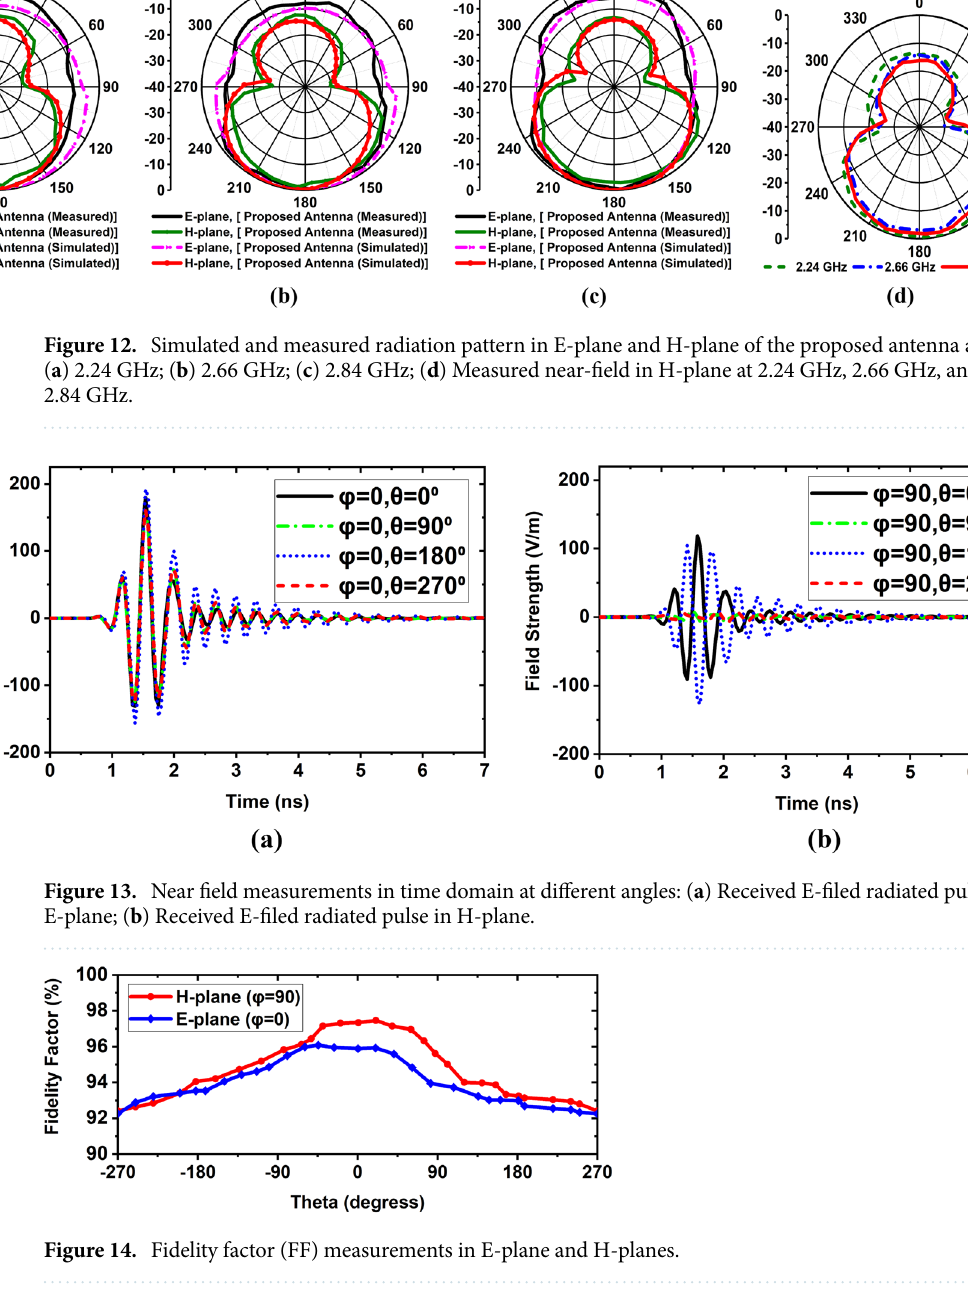
Fig. 15a,b. It is examined that when an MTM unit cell is applied to the antenna in different layers, the antenna receives almost distortionless pulses than the without an MTM-based antenna. As a result, the proposed antenna (MTM-based) exhibits a higher fidelity factor for four cases. The calculated FFs are 84.42%, 86.24%, 90.93%, and 91.01% for SBS-X-axis, SBS-Y-axis, FTF-Z-axis, BTB-Z-axis without MTM respectively, whereas 93.41%, 94.52%, 95.20% and 98% for SBS-X-axis, SBS-Y-axis, FTF-Z-axis, BTB-Z-axis with MTM respectively. However, it is concluded that the proposed antenna is performed better in both far-field and near-field. Thus, it is a suitable candidate in the microwave brain imaging system, where the antenna has to be set up in a Back-to-Back (BTB, Z-axis) orientation to get better performance.